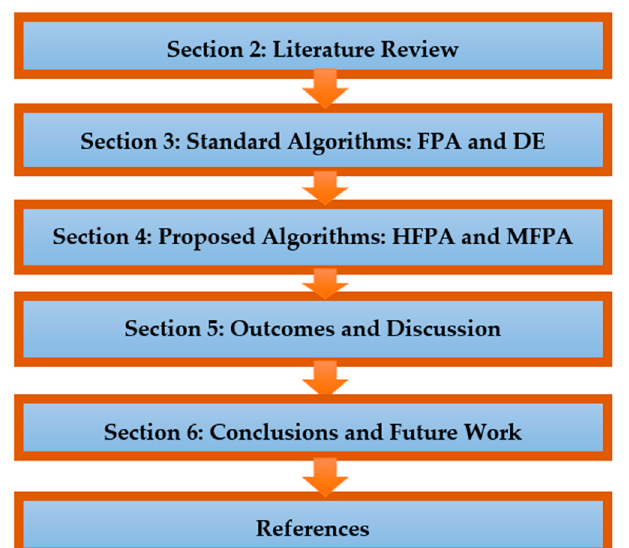
Figure 1. Flowchart of the paper organization.